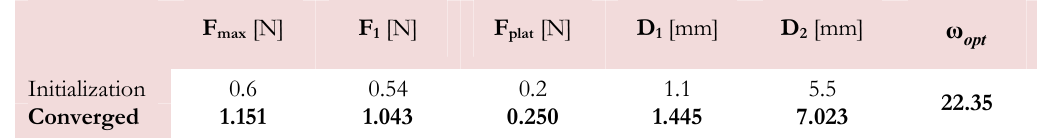
Table 2: Initialization vector and parameter values returned by the minimization of the discrepancy function ω based on the crack opening profile only.